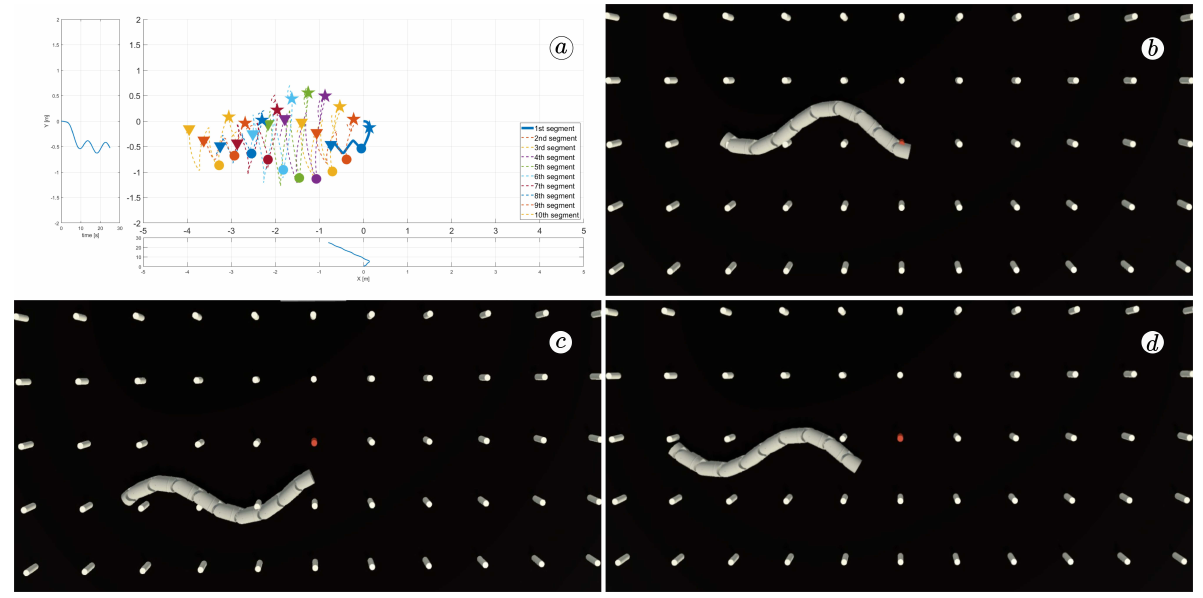
Figure 11. Trajectories of robot segments for c t = 10 and c n = 1 ( a ) and robot configurations for t = 5 ( s ) ( b ), t = 10 ( s ) ( c ), and t = 24 ( s ) ( d ). Figure 10 indicates that the robot requires anisotropy of friction coefficients to move.